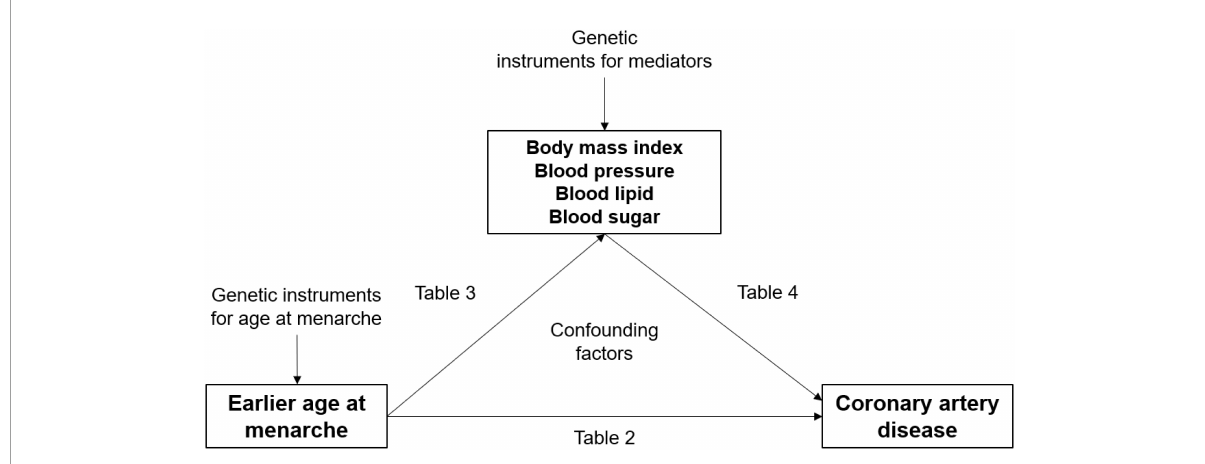
FIGURE1 Observational and genetic associations/mediations investigated in the present